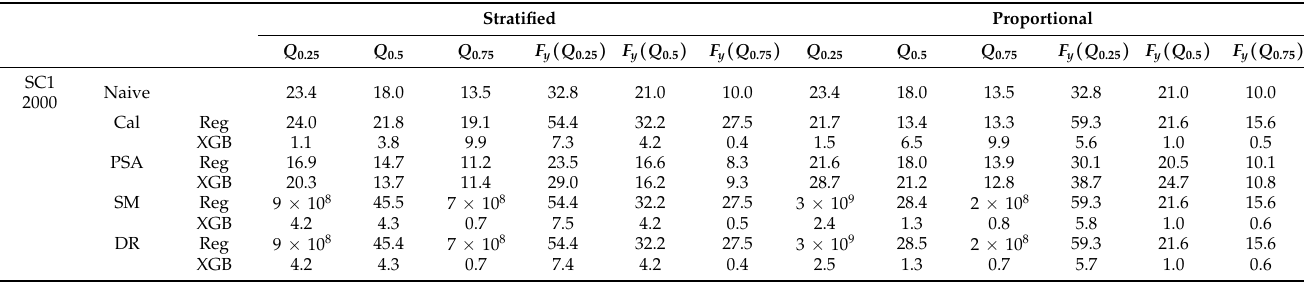
Table 2. RMSE (%) for each reference probability sample, parameter, non-probability sampling and size, method, and machine learning model (linear/logistic regression or XGBoost). Stratified Proportional Q